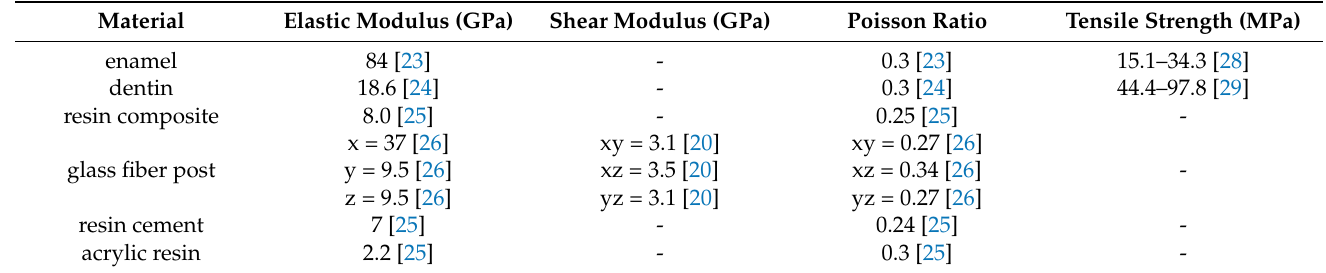
Table 1. Stress peaks (MPa) obtained in enamel and dentin tissue after the analysis process.